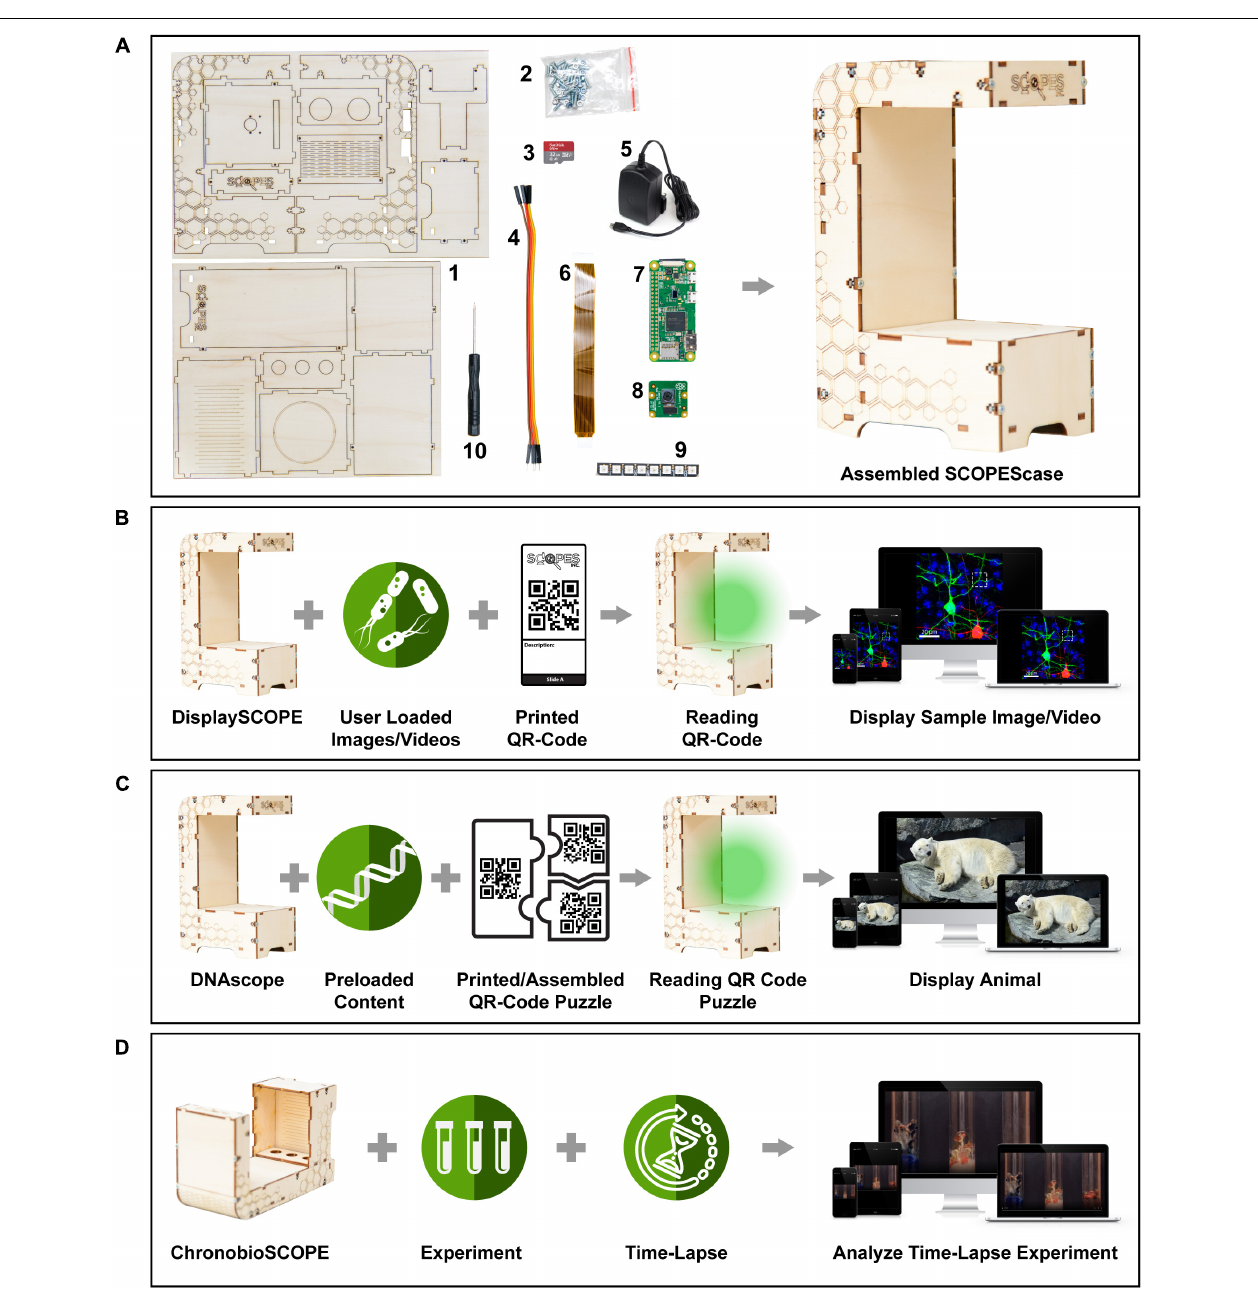
FIGURE 1 | Overview of SCOPES Education Platform. (A) Components required to assemble a functioning SCOPEScase. Parts include (1) Laser-cut wood case, (2) M3 Screws and nuts, (3) SD Card, (4) Male to female jumper cables, (5) 5V power adapter/power supply, (6) Pi Zero camera cable, (7) Raspberry Pi Zero W, (8) Raspberry Pi Camera v1 or v2, (9) Pimorini Blinkt LED, and a (10) Screwdriver. Right panel depicts a fully assembled SCOPEScase. The assembled SCOPEScase is not strictly necessary for all activities in (B–D) , but greatly improves the user experience and ease-of-use. (B) Operation in DisplaySCOPE mode. Requires user to load an image and/or video content and link to QR-code through the web interface as well as to print QR-codes. When the QR-code slide is scanned by the DisplaySCOPE, the sample is displayed on the connected device. (C) Operation in DNAScope mode. Content is provided preloaded on the Raspberry Pi disk image (https://scopeseducation.org/downloads/). Requires users to print provided QR-code puzzle pieces. When a complete puzzle is assembled and scanned by the DNAscope the corresponding animal/plant is displayed on the connected device. (D) Operation in ChronobioSCOPE mode. Depending on the samples, users can perform experiments with SCOPEScase in a vertical or horizontal position. Time-lapse settings are defined in the web interface and analysis of the experiment can be viewed on the connected device. For complete assembly and operation instructions please see https://scopeseducation.org.